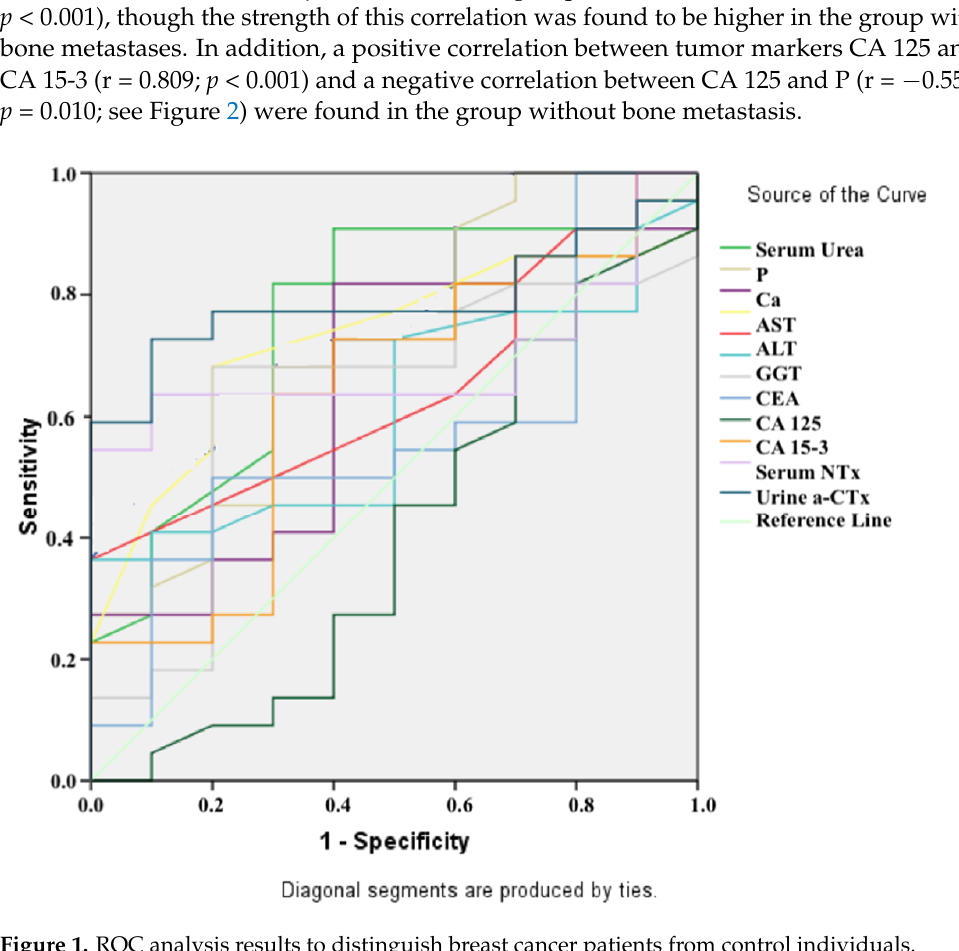
Figure 1 . ROC analysis results to distinguish breast cancer patients from control individuals. Figure 1. ROC analysis results to distinguish breast cancer patients from control